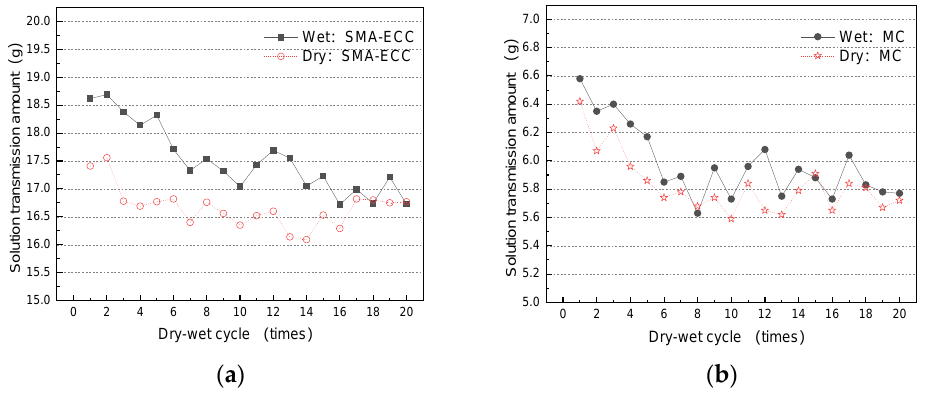
Figure 10. Transport behavior of chloride salt solution of specimens under different times of dry-wet corrosion cycle. ( a ) SMA-ECC ( b ) MC.